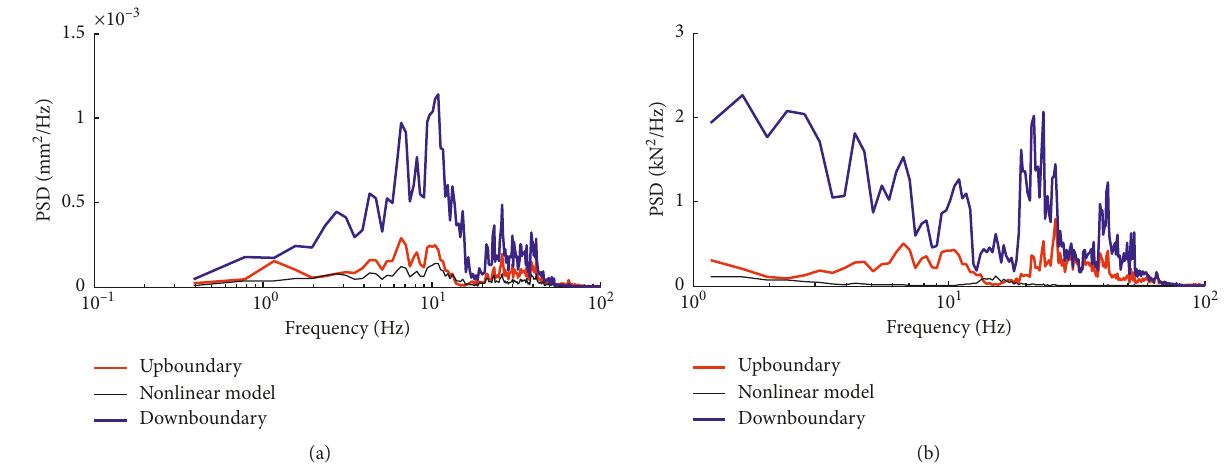
Figure 8: The up- and downboundary PSDs of the linear model and the PSD of the nonlinear model. (a) Rail lateral displacement. (b) Wheel-rail lateral